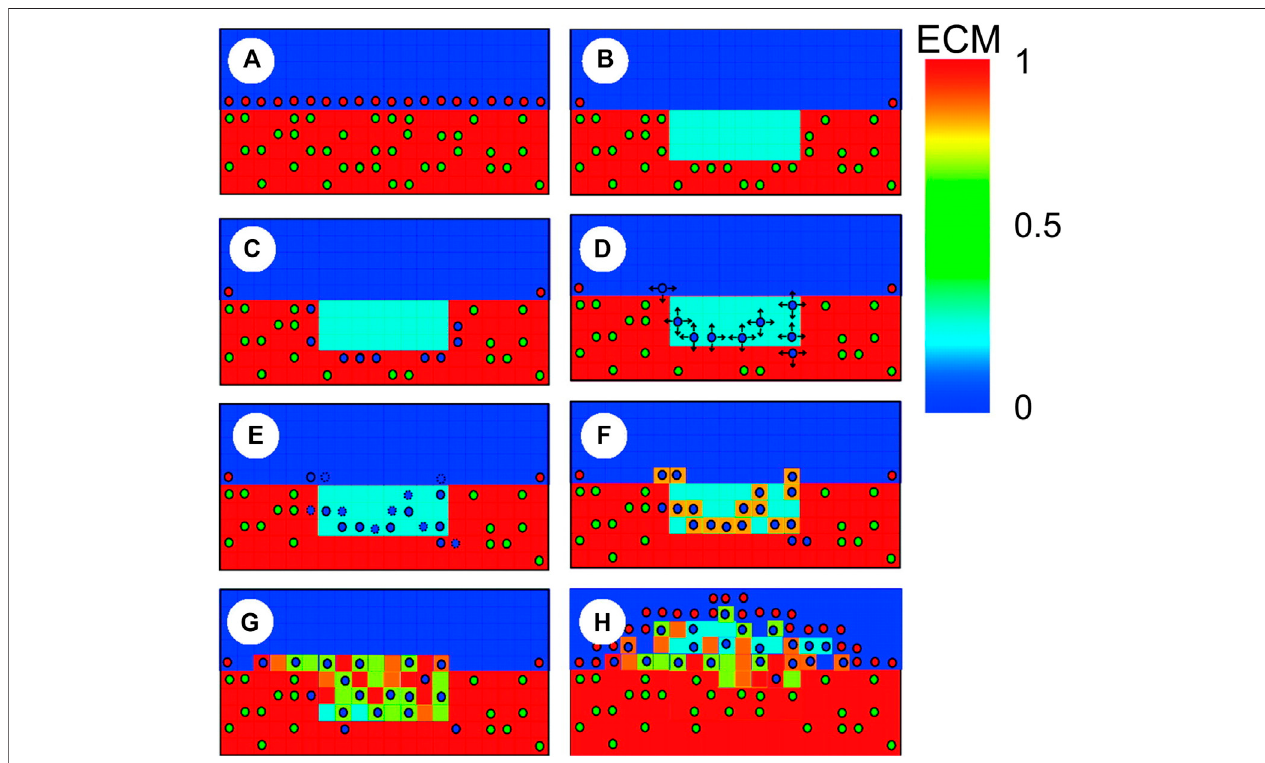
FIGURE 8 | Schematic representation of agent-based model (ABM) rules in Boyle et al. (2010), with contractile smooth muscle cells (SMCs) (green circles), synthetic SMCs (blue circles) and endothelial cells (red circles). (A) When the endothelium and extracellular matrix (ECM) are intact, SMCs are contractile; (B) The injury provokedbythe stentplacementinduces endothelialdenudation, ECM reduction and SMCsremoval; (C) InthevicinityofdegradedECM, SMCsswitch tothesynthetic phenotype; (D) Synthetic SMCs randomly migrate (arrows represent possible directions); (E) Synthetic SMCs proliferate (blue circles with dashed lines represent daughter cells); (F) SMCs produce ECM; (G) Lesion formation; (H) Reendothelialization stops lesion growth. Reprinted with permission from Boyle et al. (2010) (http://